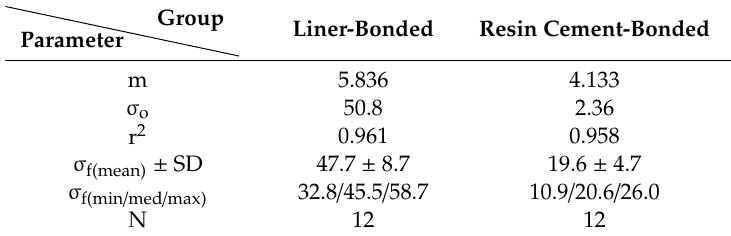
Table 1. Weibull analysis data of a microtensile bond strength test for lithium disilicate-reinforced glass ceramic and zirconia of the liner-bonded group and the cement-bonded